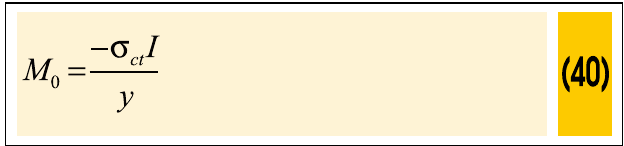
Figure [4] shows the stress-strain diagram for rectangular sections of prestressed FRP post-strengthened reinforced concrete beams.